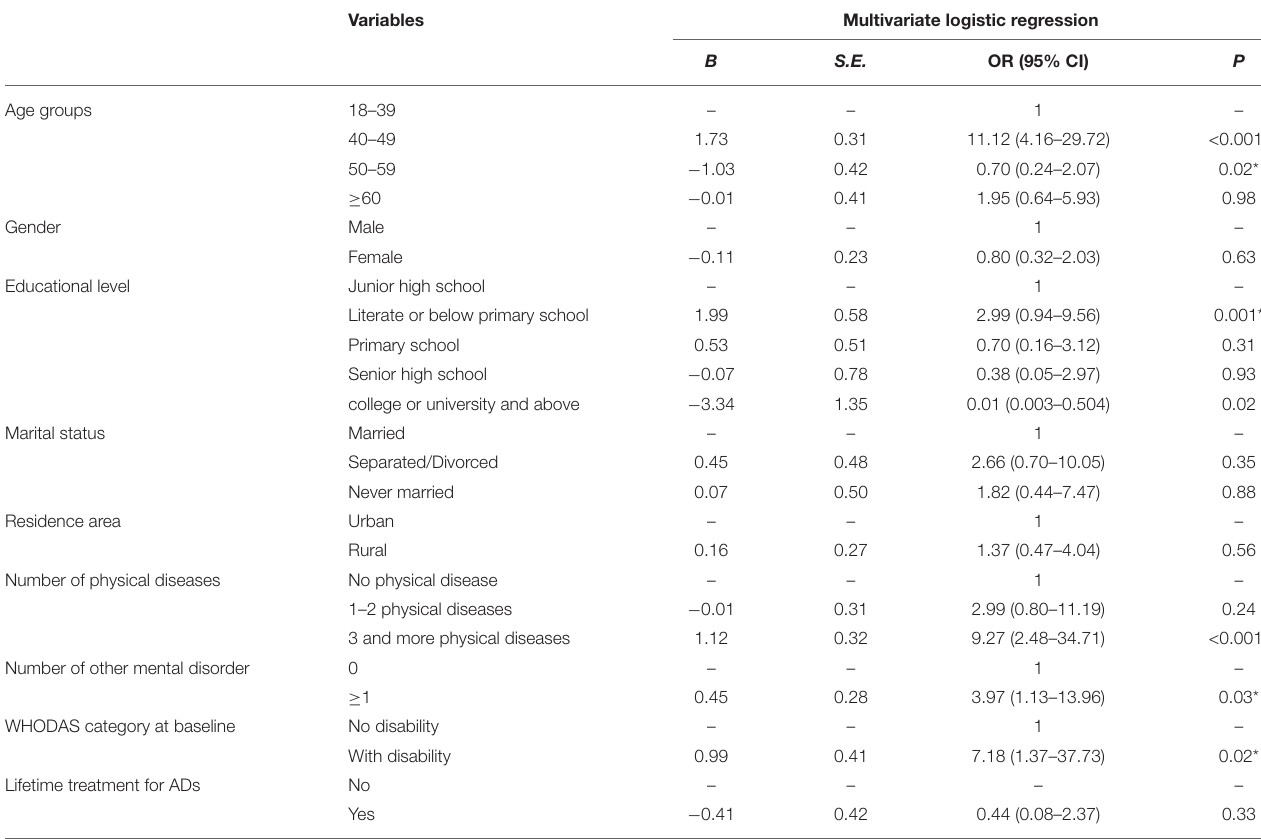
TABLE 3 | Odds ratios of determinants in anxiety disorders, corresponding 95% confidence intervals (CI), and p -values obtained by multiple logistic regression models with disability as outcome